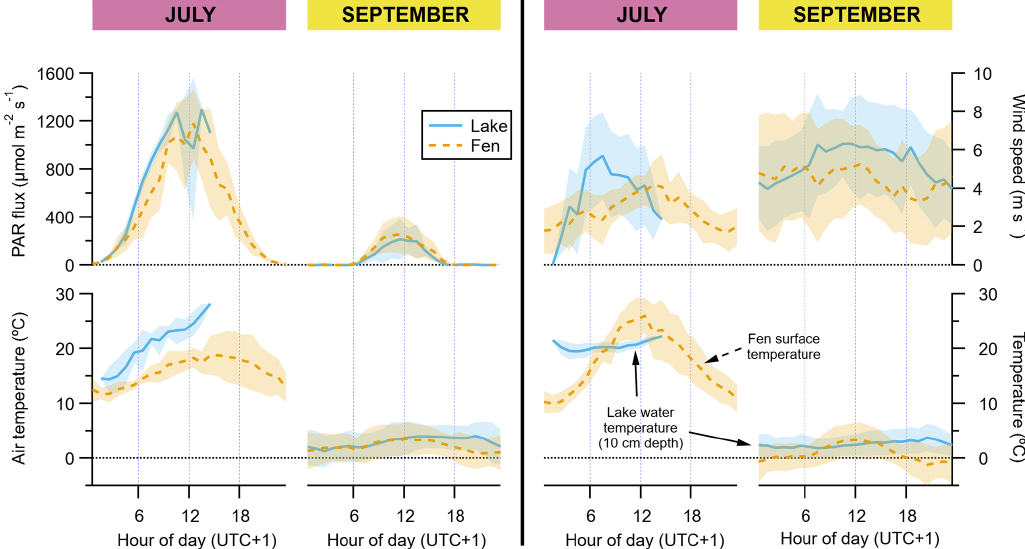
Figure 2. Diel cycles of hourly averages of meteorological data, for July and September and for both the lake (solid blue lines) and the fen (dashed orange lines). The peak of the growing season (July) is on the left subpanel of each graph pair, and the post-growing season (September) is on the right subpanel, as indicated on top of the panels. Shaded areas represent ± 1 standard deviation. Each vertical axis has a different scaling, but all of them feature a horizontal dotted line showing where the value zero is located. Table 1. Average ( ± standard error of the mean) daily net exchange rates (µmolm − 2 d − 1 ) of VOCs, CO 2 , H 2 O, and CH 4 . Negative values represent net deposition or uptake by the ecosystem, and positive values represent net emission. These daily averages were calculated from the hourly averages shown in Figs. 3 and